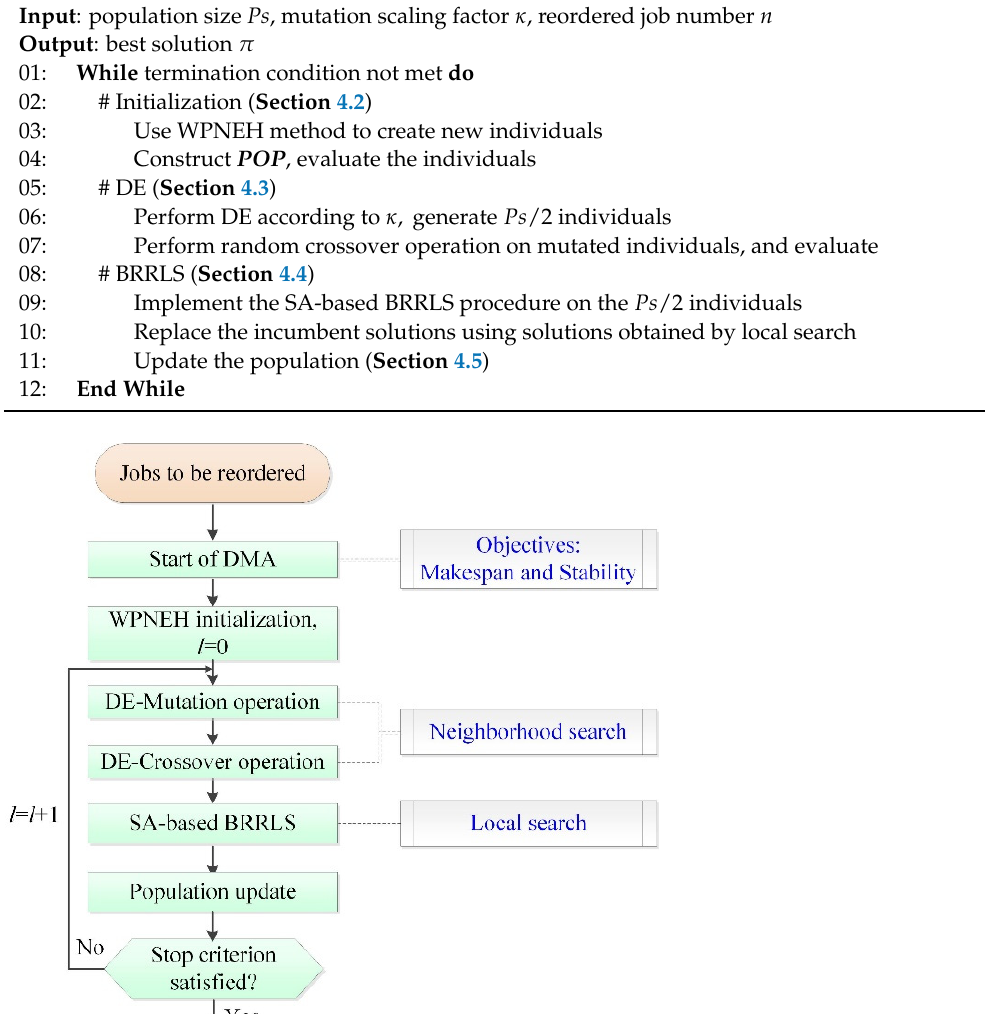
Algorithm 5 Flowchart of DMA